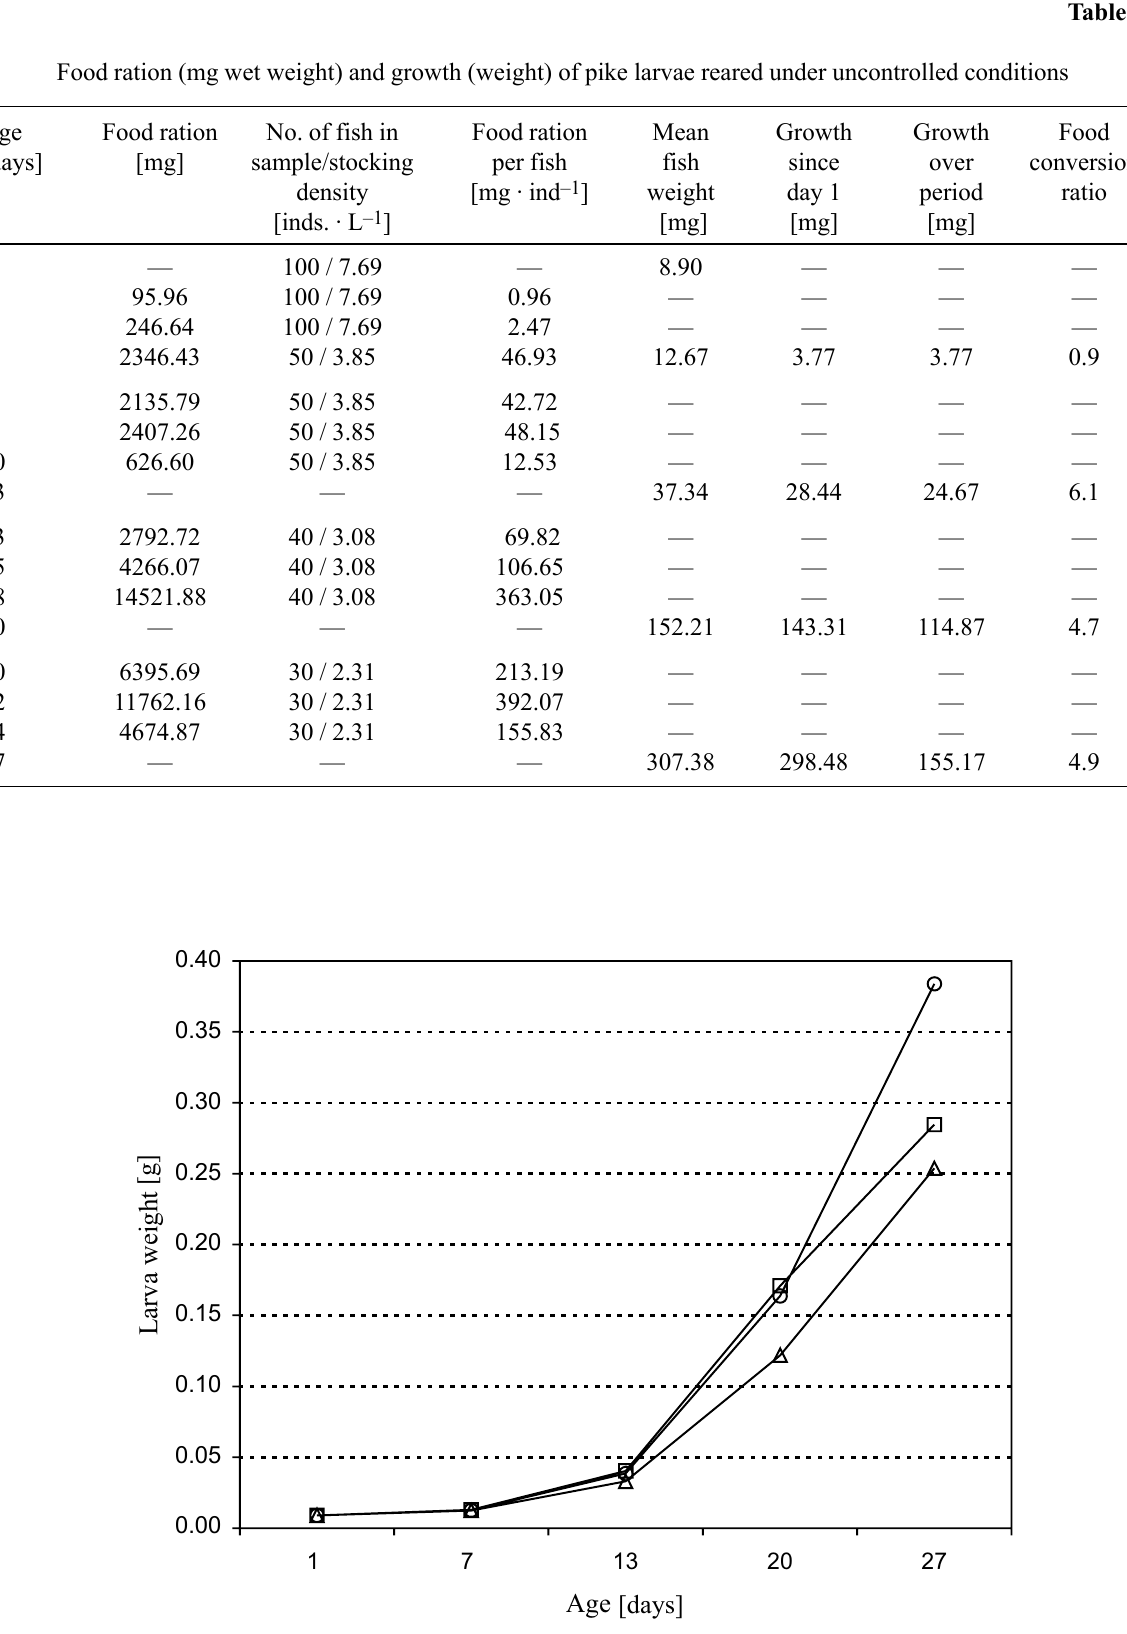
Fig. 3. Mean individual weight of pike larvae during growing-out operation in tanks with different habitats. Tanks with black garden polyethylene foil (F) denoted with ! ; tanks with vascular plants (R) denoted with " ; tanks with plastic netting (S)